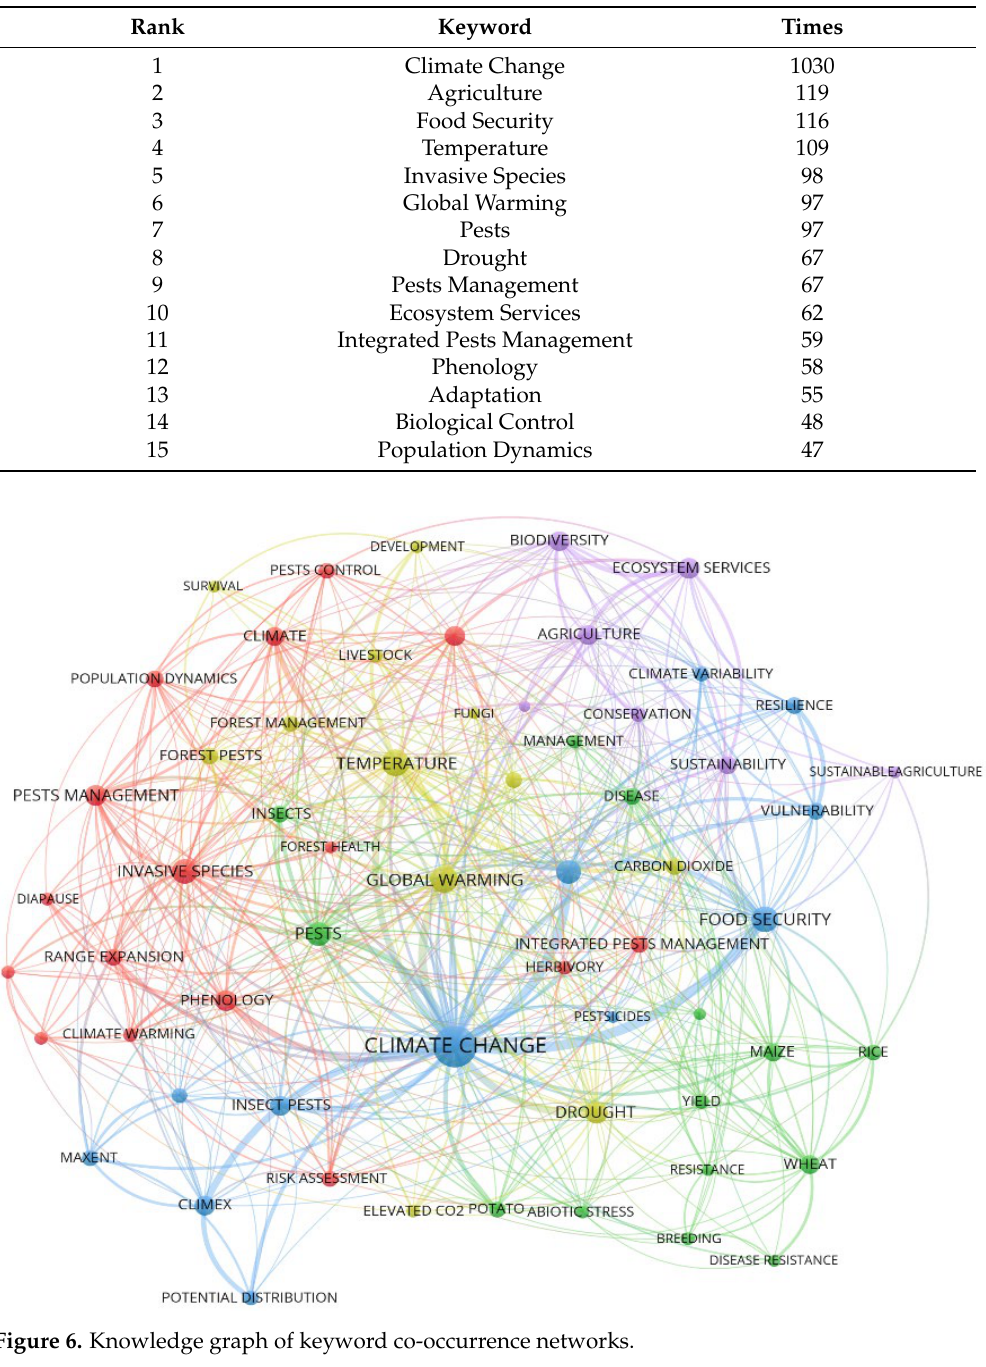
Figure 6. Knowledge graph of keyword co-occurrence